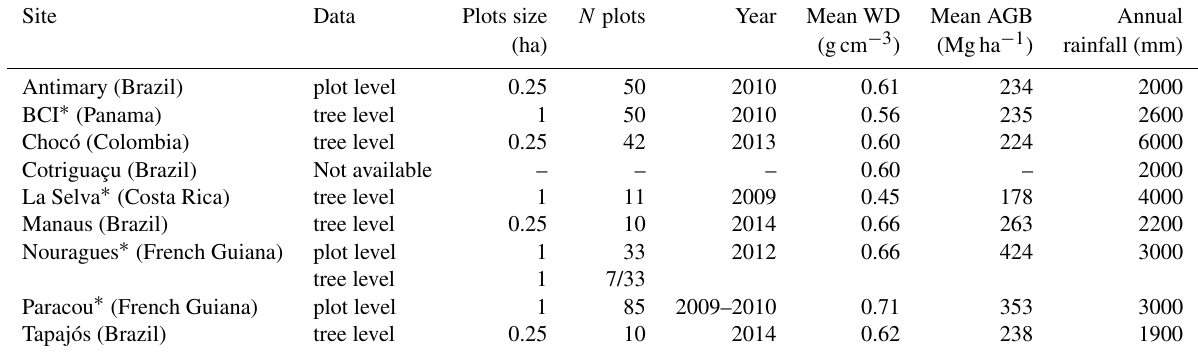
Table 1. Information on forest inventory plots. The ∗ symbol indicates that a site has been used for the calibration of the LCA model. Sources: Antimary and Cotriguaçu: (d’Oliveira et al., 2012; Fearnside, 1997), BCI: Center for Tropical Forest Science (CTFS; Condit, 1998; Hubbell et al., 1999, 2005), Chocó: (http://bioredd.org, last access: 13 April 2016), La Selva: Carbono project (Clark and Clark, 2000), Manaus and Tapajós: Fernando Espírito-Santo (unpublished data), Nouragues: (Réjou-Méchain et al., 2015), Paracou: (Gourlet-Fleury et al., 2004; Vincent et al., 2012). Rainfall data from WorldClim (Hijmans et al., 2005). AGB: aboveground biomass, WD: wood density.